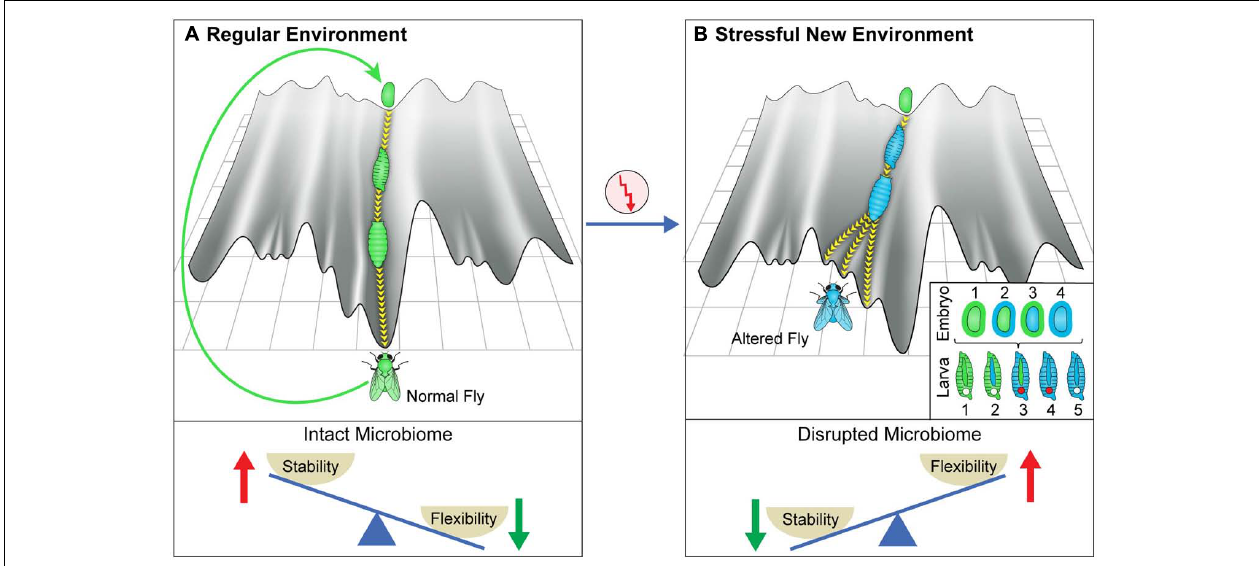
result in altered somatic tissues, altered germline and altered microbiome. Inset provides color-coded representation of various potential changes in the embryos and larval stages of a developing fly that has been exposed to a new stressful external environment.The gut microbiome is represented by the outer layer of the egg and the tube in the larva.The early embryo corresponds to the inner part of the egg and the germline is represented by the circle in larva. A change in color corresponds to alteration in the respective organ following the change in the external environment. (Bottom) Proposed, context-dependent influence of the microbiome on stability/flexibility.The microbiome contributes to stabilization in the regular environment to which the organism is well adapted (left). Disruption of the microbiome in a sufficiently stressful environment (right) destabilizes the host, thereby increasing phenotypic variability (increased